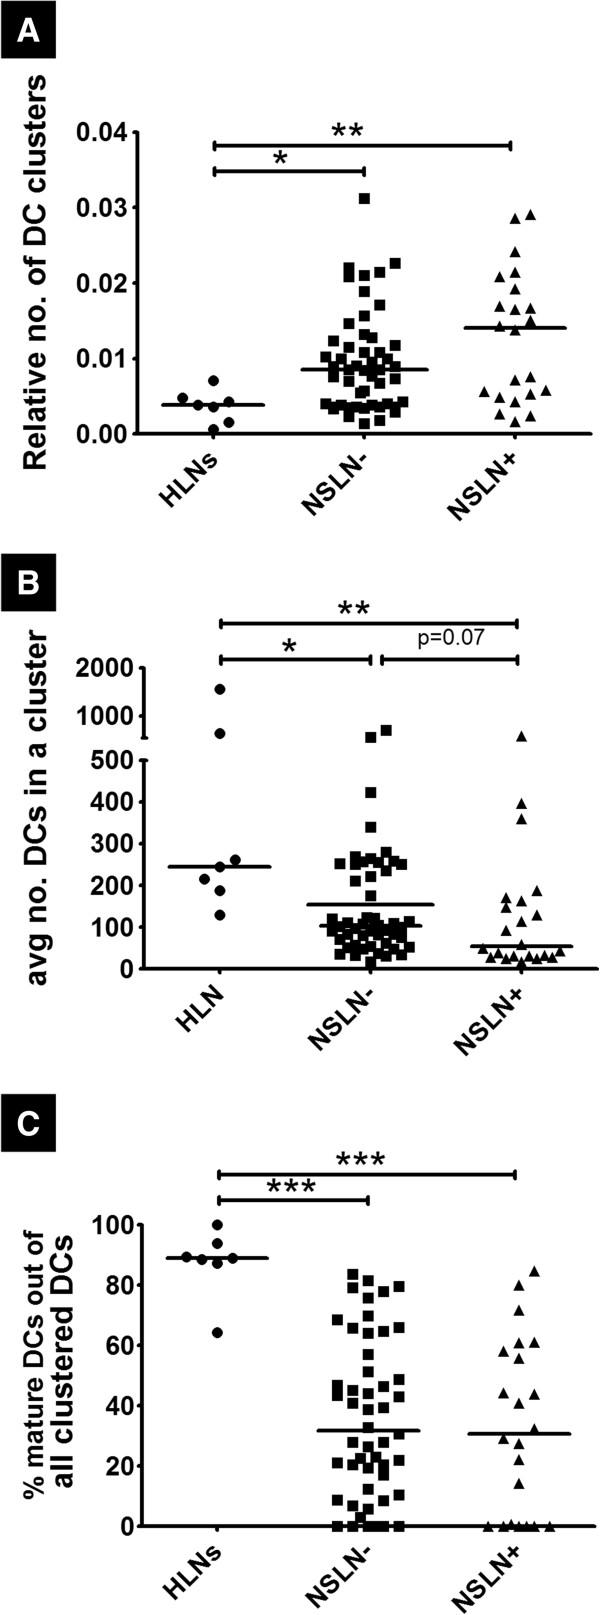
DCs in TDLNs are organized into smaller, less mature clusters compared to HLNs. (A) Number of DC clusters normalized to the total number of DCs in a node (relative number of DC clusters) (B) average size of a DC cluster in a node (calculated by taking an average of the number of DCs that make up individual DC clusters in a node) and (C) percentage of CD83 positive DCs of all clustered DCs in a node (% mature DCs out of all clustered DCs) were calculated in sections HLN (n=7), NSLN- (n=50) and NSLN+ (n=22). *denotes p<0.05, ** denotes p<0.01 and *** denotes p<0.001.